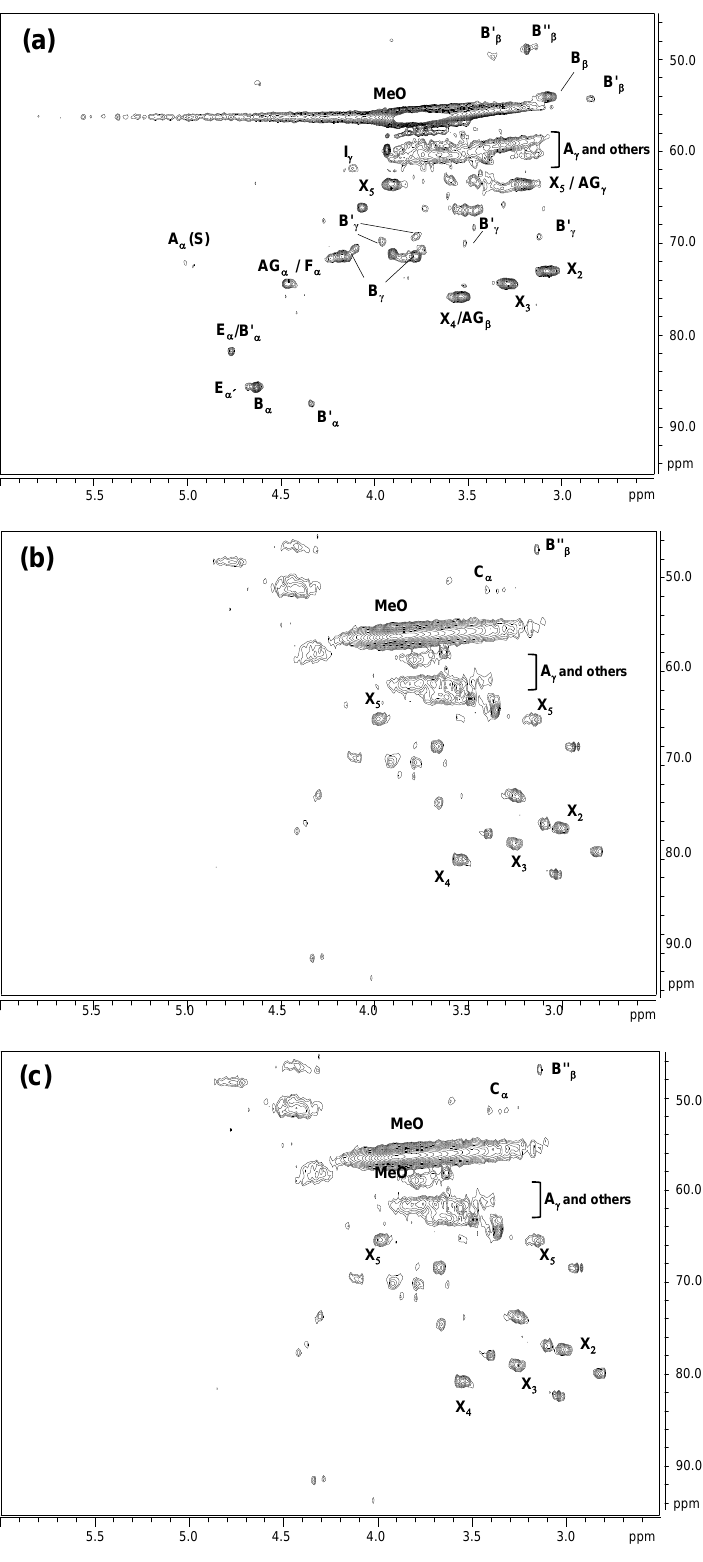
Figure 7. HSQC 2D- NMR spectra, δ C /δ H 45.0 – 95.0/2.5 – 6.0 ppm aliphatic oxygenated region, of the untreated lignin ( a ) and of the resulting treated lignins with MtL ( b ) and SiLA ( c ) laccases. Correspondences between lignin structures and assigned letters in the figure: A , β -O- 4′ alkyl -aryl ether; AG , aryl-glycerol; B , resinols; B′ , epiresinols; B′′ , diaresinol; C , α - 5´ ; E , spirodienones; F , Ar – CHOH – COOH; I , cinnamyl alcohol end-groups; X , xylopyranose (R, OH).